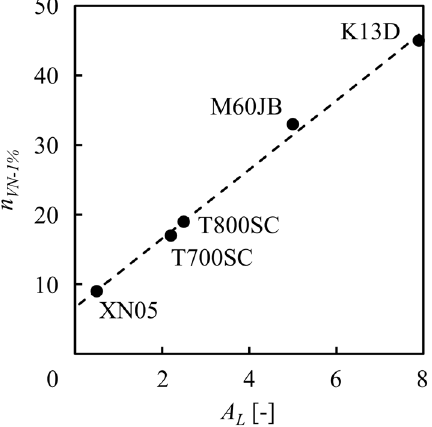
) and minimum subinterval number L error below 1% in various com- VN